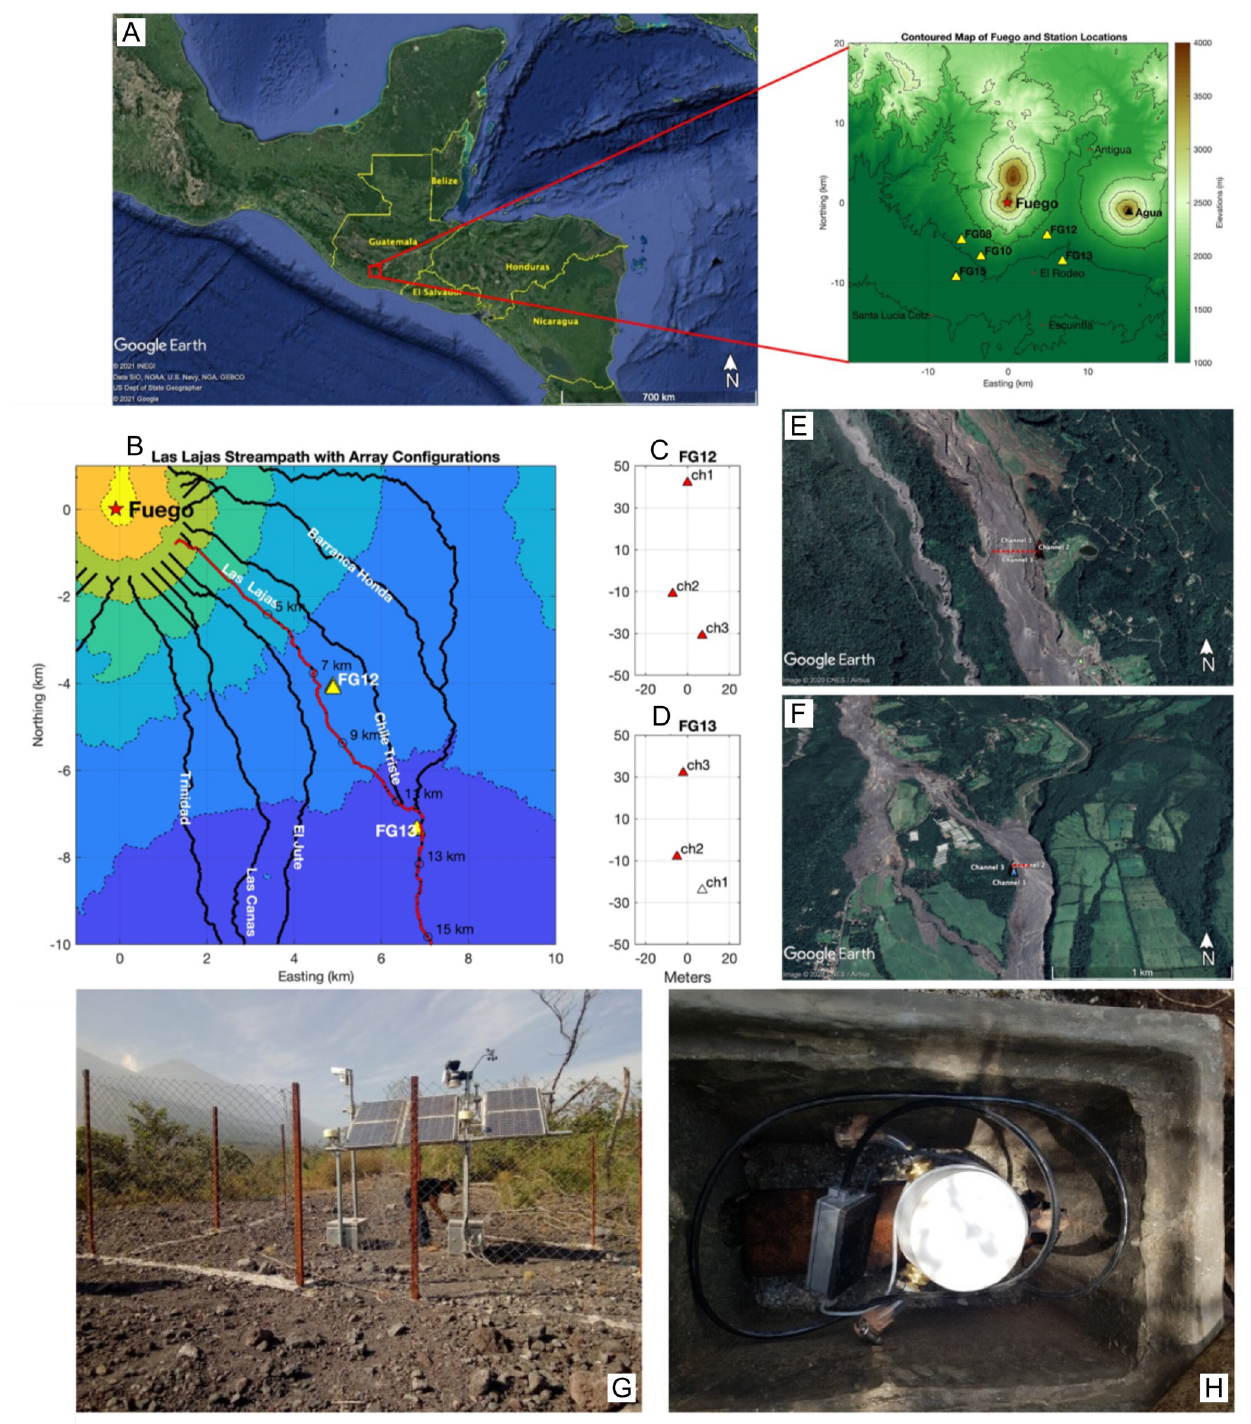
Figure 2: [A] Map of Guatemala with contoured (500m) DEM derived from SRTM showing locations of seismo- acoustic network and several population centers (inset). The Volcán de Fuego summit is indicated with a red star. [B] Drainages (thick black lines) derived from a gradient seed on a contoured SRTM DEM with the Las Lajas drainage highlighted in red. [C and D] Detailed array maps for stations FG12 and FG13, located at flow path dis- tances of approximately 7.5 and 12 km, respectively. Channel 1 (clear triangle) at FG13 was not operational during the featured event. [E and F] Show relative distances of infrasound sensors from drainage (dashed lines repre- sent ~200 m at FG12 (top) and À 100 m from FG13 (bottom)) (Google Earth images from November 2018 taken by Maxar Technologies and CNES/ Airbus). [G] Infrasound station set up at FG12; [H] Infrasound sensor encased in concrete at station